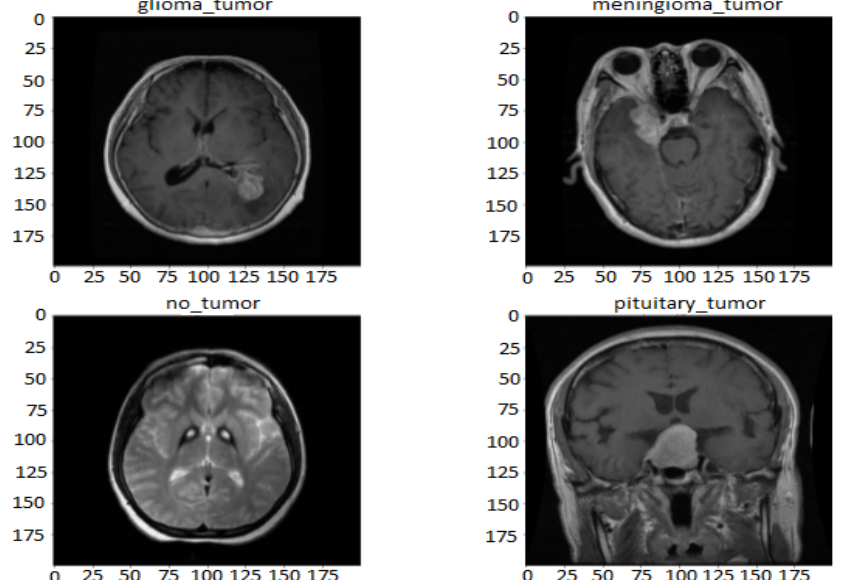
Figure 2. Images of the normal brain and the other three types of brain tumors—Glioma, Meningioma and Pituitary.